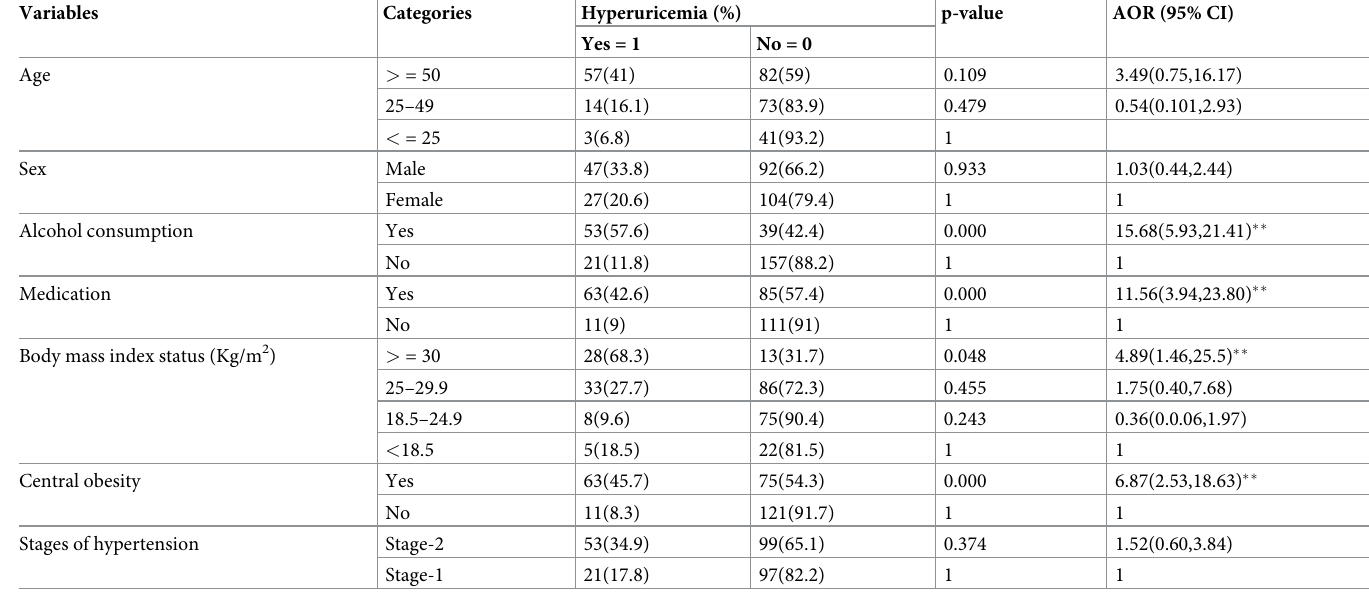
Table 4. Multivariate analysis of factors associated with hyperuricemia among adult essential hypertensive patients at Wolkite University specialized hospital, Wolkite, Southern Ethiopia, from November 1 to February 30,